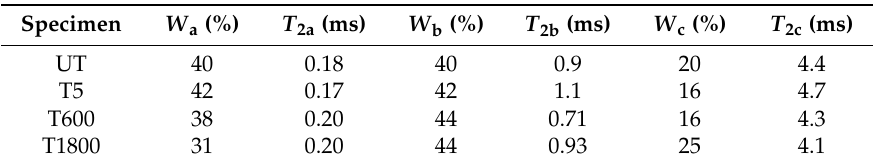
Table 4. T 2 relaxation times and relative populations measured in sandstone specimens. The error on the parameters is less than 10% of the nominal value.